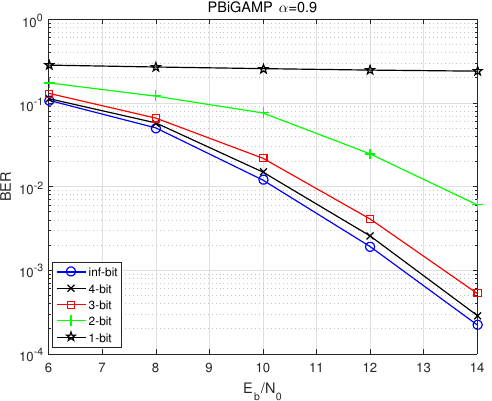
Figure 8. BER performance versus E b / N o at 10-th Turbo iteration of the proposed algorithm under different quantization